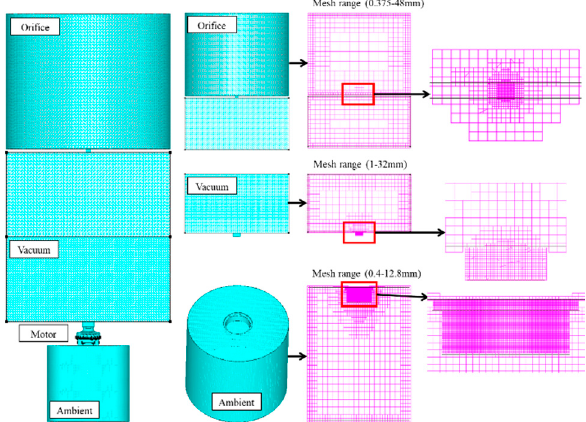
Figure 11. Simulation modeling to estimate the fluid dynamics of single-phase BLDC motor inside vacuum cleaner.